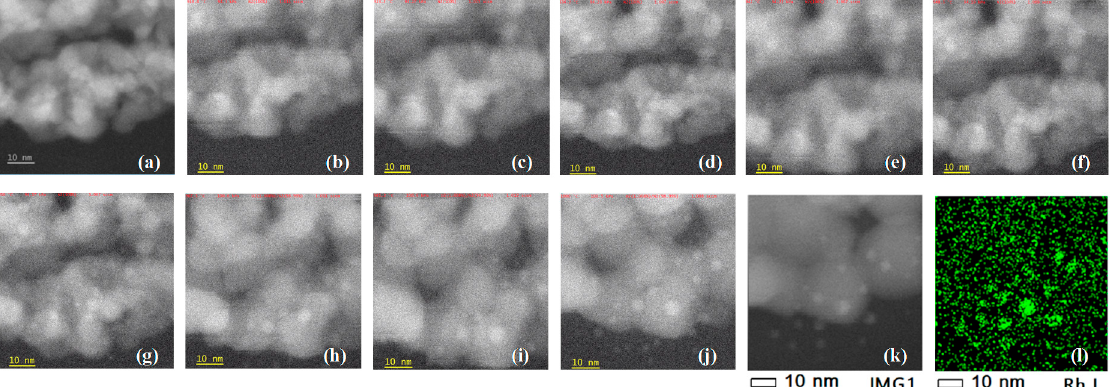
Figure 9. In situ TEM images of Rh/Y-ZrO 2 at ( a ) 300 °C, ( b ) 910.4 °C, ( c ) 923.2 °C, ( d ) 934.2 °C, ( e ) 942 °C, ( f ) 948.5 °C, ( g ) 950 °C, ( h ) 967.3 °C, ( i ) 985.2 °C, and ( j ) 1000 °C. ( k ) TEM results at 300 °C after cooling from 1000 °C. ( l ) EDS measurement result after (j) at the same observation point. The atmosphere was N 2 in ( a )–( g ) and changed to 1% O 2 /N 2 in ( h )–( j ).